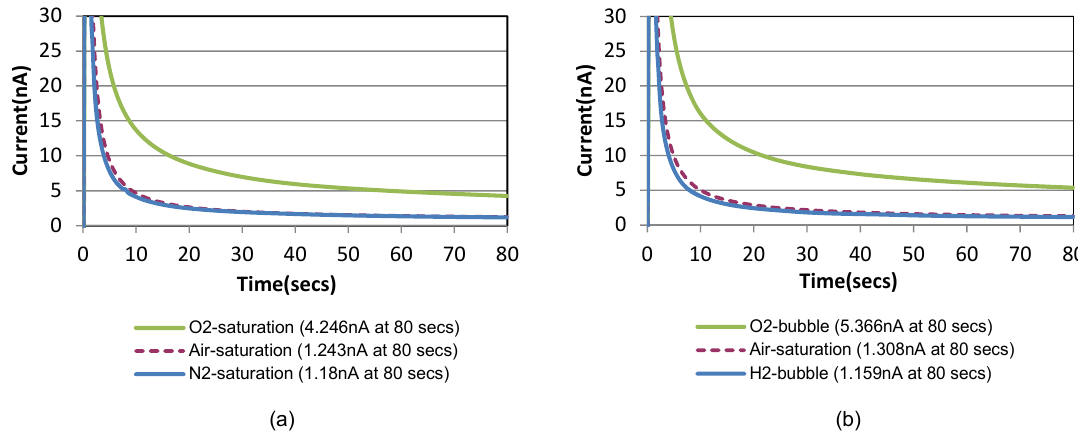
Figure 4. Comparison of chronoamperometric time responses for a creatinine concentration of 10 mg/dL (t = 0 s corresponds to t = 150 s in Figure 3). ( a ) Sensor placed in a beaker filled with a creatinine solution saturated or depleted of oxygen by purging with oxygen or nitrogen cylinder. ( b ) Same sensor mount on the fluidic chip at optimized final distance 1 mm and current density 5.5 mA/cm 2